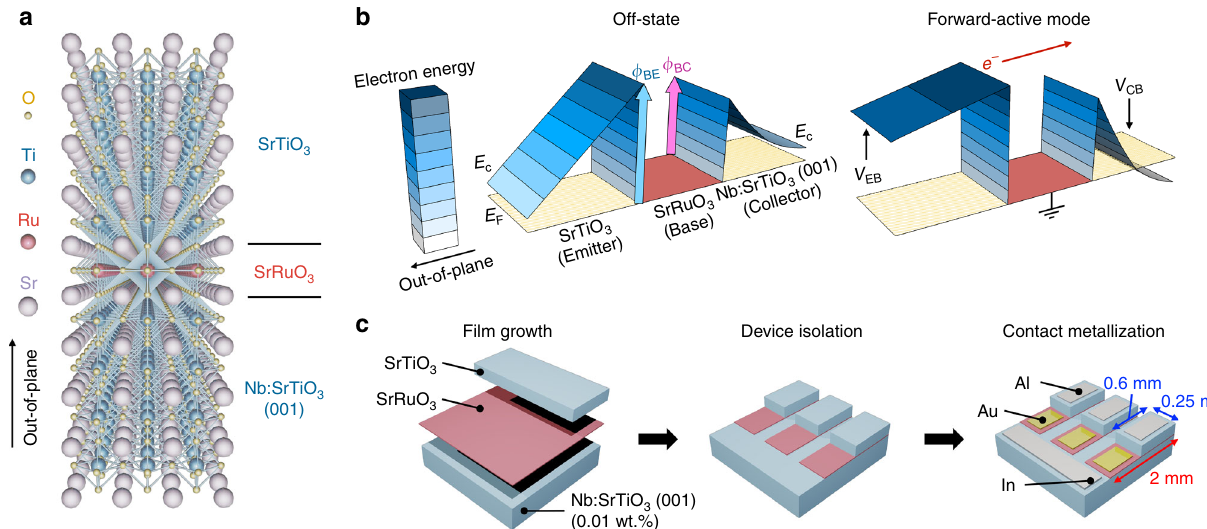
Fig. 1 Schematics and working principle of the perovskite hot-electron transistor (HET). a The crystal structure of the atomically thin HET with a SrTiO 3 emitter/SrRuO 3 base/Nb:SrTiO 3 (001) collector trilayer. b Schematic illustration of the HET energy band diagram in the off-state (left) and in the common- base forward-active mode (right). In device operation, hot electrons are injected across the forward-biased base – emitter (BE) junction, traverse across the grounded base, and are collected across the reverse-biased base – collector (BC) junction. c Device process fl ow of the HET with laterally staggered electrical